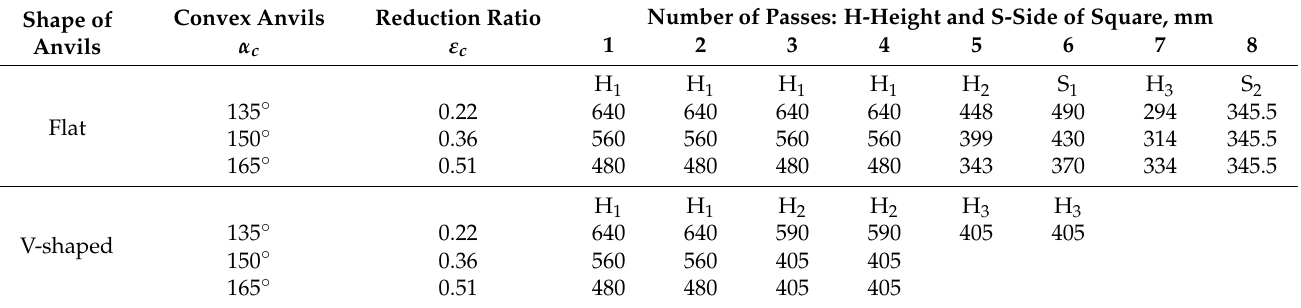
Table 1. Schedule of the cogging